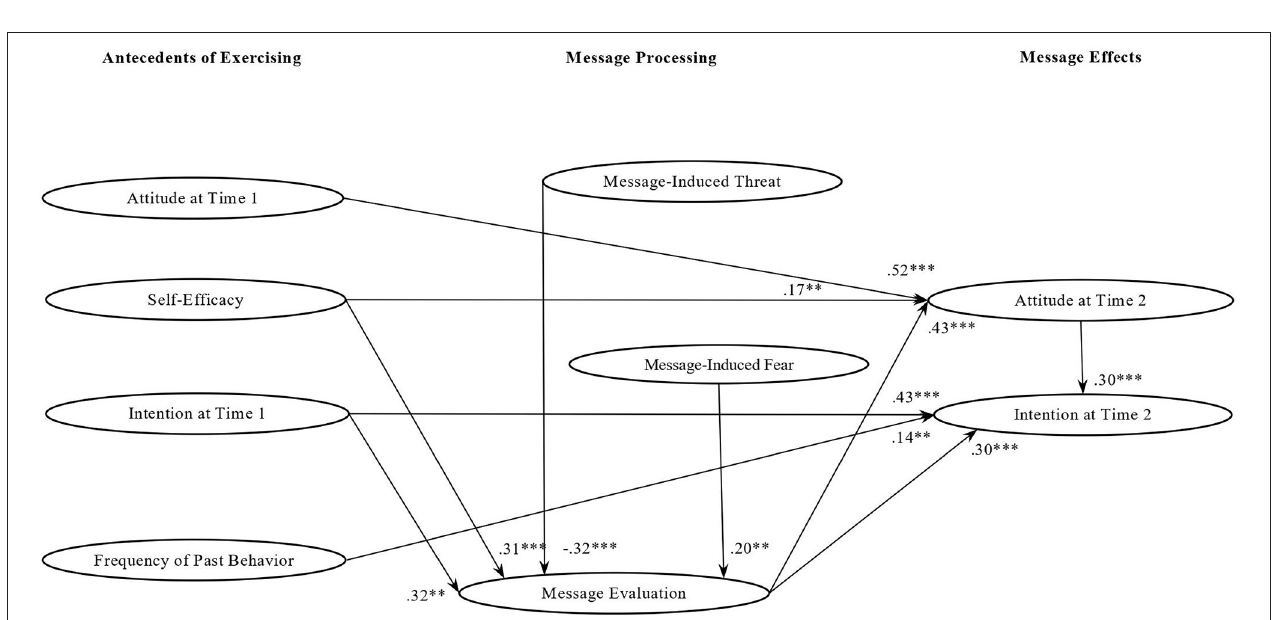
FIGURE 2 | Standardized factor loadings of the relationships among study variables in the non-loss message group. ** p < 0.05; *** p < 0.001.